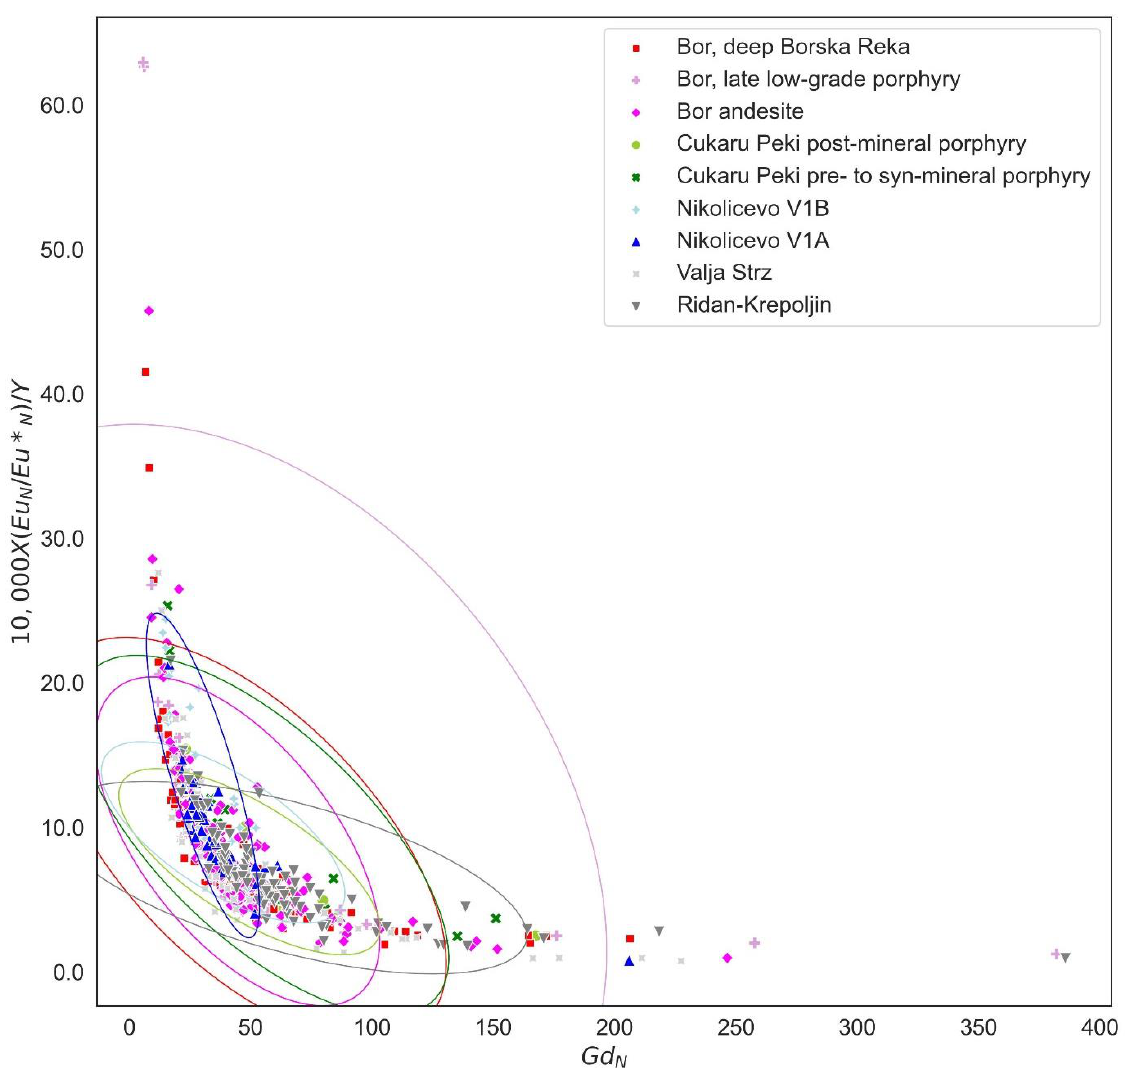
Figure 10. 10,000*(EuN/Eu*N)/Y vs. GdN of zircons, showing the difference in the slope of the confidence ellipses for mineralized samples (steep slope) and weakly mineralized or barren samples (flat slope).